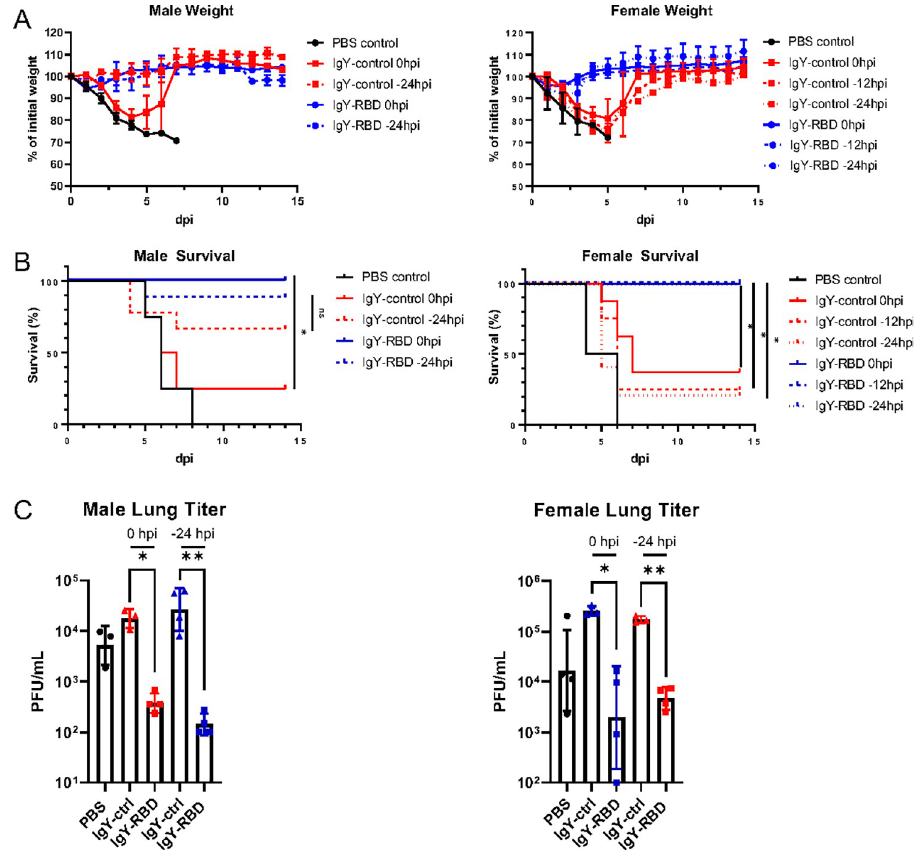
Fig 7. IgY-RBD confers in vivo protection in SARS2-N501Y MA30 -infected BALB/c mice. Male and female mice were treated with IgY-RBD or IgY-control or PBS at the indicated times prior to intranasal challenge with SARS2-N501Y MA30 . (A, B) Weight (A) and survival (B) were monitored daily. (C) Levels of infectious virus in the lungs were determined at 5 days post infection. (A and B) Male: n = 4 for PBS, IgY-control 0hpi and IgY-RBD 0hpi; n = 9 for IgY-control -24hpi and IgY-RBD -24hpi. Female: n = 4 PBS, IgY-control -12hpi; n = 5 IgY-control -24hpi, IgY-RBD (0hpi, -12hpi, -24hpi); n = 8 IgY-control 0hpi. (C) each symbol represents data obtained from one individual mouse. Data in (A) are mean ± s.e.m. Data in (C) are geometric mean ± geometric SD. P values determined by two- tailed Student’s t test. Data are pooled from three independent